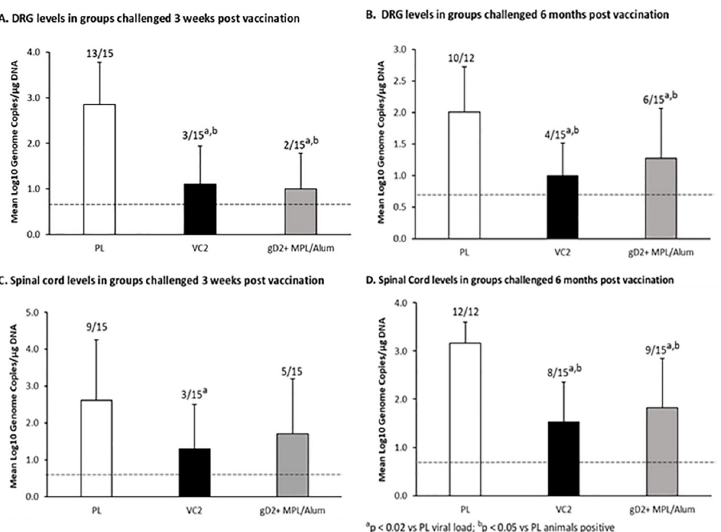
Fig 2. Effects of vaccination on HSV-2 DNA levels in the DRG and spinal cords at the completion of the observation period (day 63 post vaginal virus challenge). Panel A, levels in the DRG in the animals challenged at 3 weeks post vaccination, Panel B animals challenged at 6 months post vaccination, Panel C levels in the spinal cord in animals challenged at 3 weeks post vaccination, Panel D animals challenged at 6 months post vaccination. The number of animals with detectable virus DNA/total number animals evaluated are shown above each bar. Error bars are the standard deviation (SD).